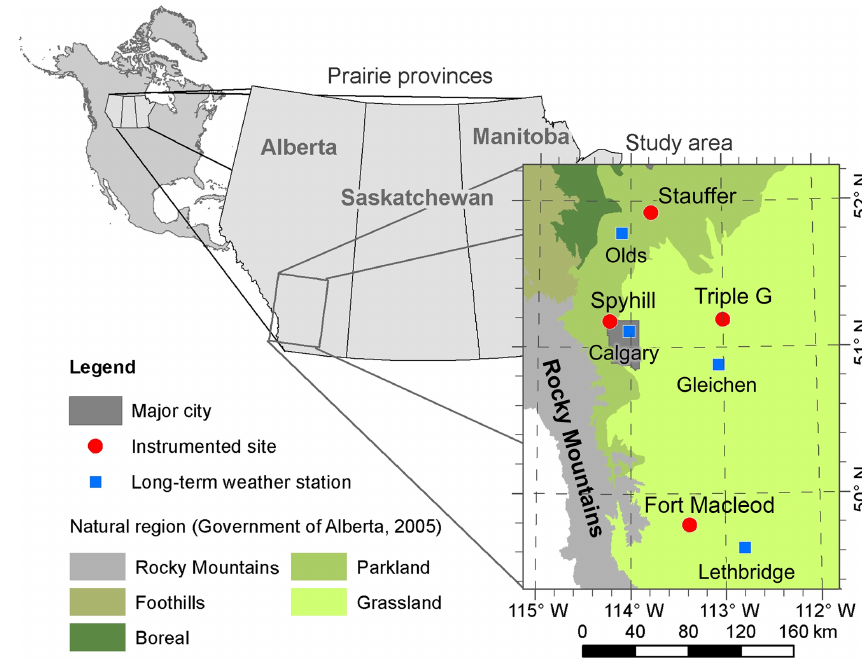
Figure 1. Location of the study sites. Parkland is a transition zone between semi-arid grassland and humid boreal natural regions. Table 1. Average precipitation (Mekis and Vincent, 2011) and air temperature (Vincent et al., 2012) at long-term climate stations close to the study sites, and the distance to the mountains from the study